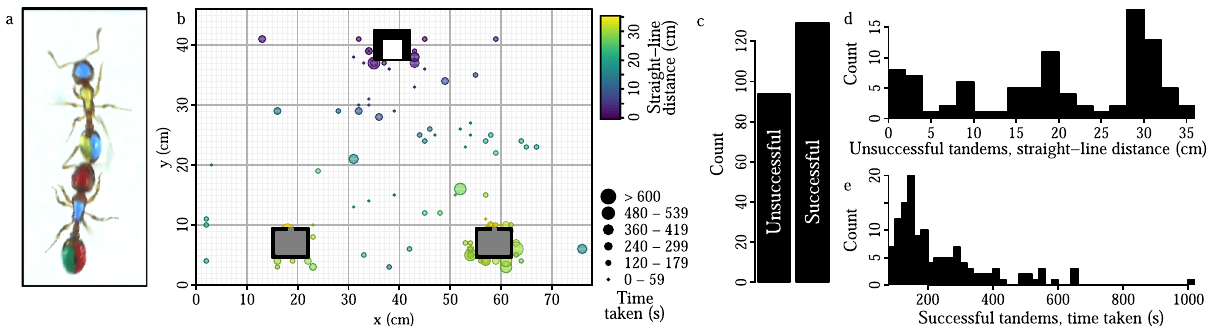
Fig. 1 Quantifying tandem run performance in Temnothorax nylanderi ants. a A tandem run between two workers each marked with a unique paint colour combination. The ant with paint code BYYB (Blue head, Yellow thorax, Yellow left gaster, Blue right gaster) leads, and ant RBGR (Red head, Blue thorax, Green left gaster, Red right gaster) follows. b The emigration arena. The initial low-quality nest is shown in white (top), and the two high-quality nests in grey (bottom). Points indicate the spatial distribution of the break-up locations of unsuccessful tandem runs. Successful tandem runs terminated inside a new nest, hence their end locations are not shown. c Breakdown of successful versus unsuccessful tandem runs observed during the fi fth emigration. Histograms show the distribution of the straight-line-distances for unsuccessful tandem runs d , and the time taken by successful tandem runs e